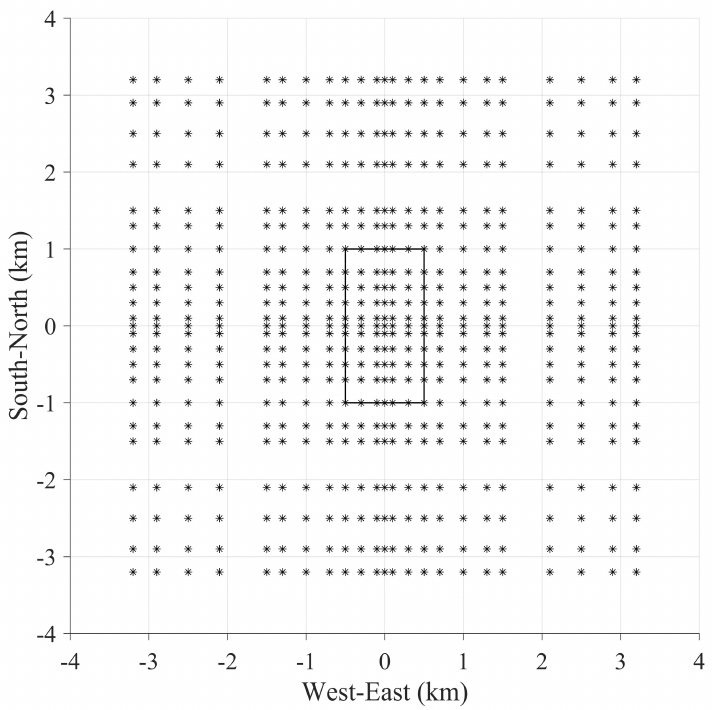
Figure 5. Plan view of COMMEMI 3D-1A model. The * symbols denote the observed sites. The rectangle is the projection of the anomalous prism on the earth’s